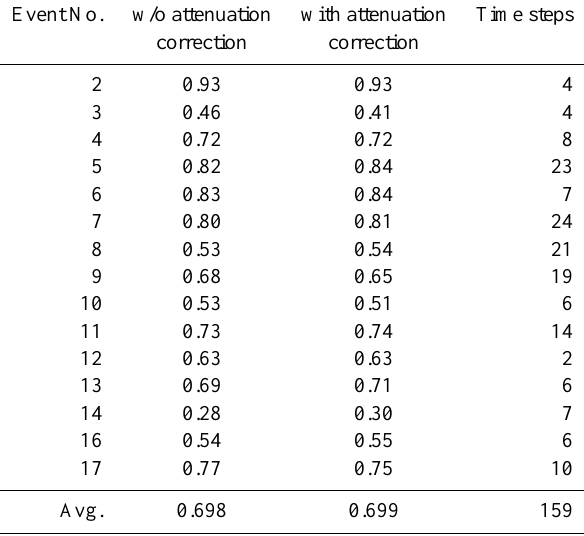
Table 2. Correlation between precipitation at all recording-stations and radar rainfall intensities for time steps exceeding a threshold of 1.0 mm/h of average precipitation. Event No. w/o